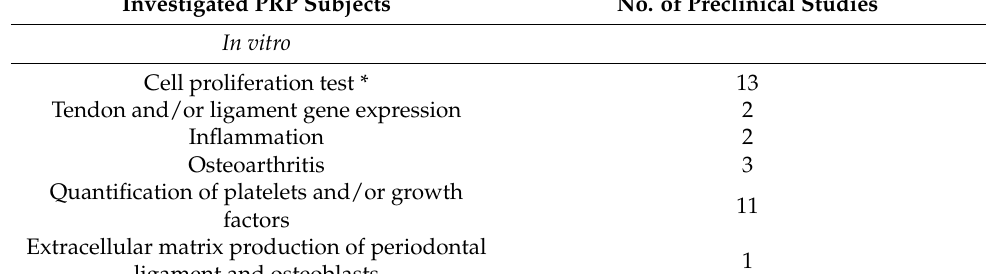
Figure 6. Type distribution of articles. Bar graph showing the median number of citations (and maximum) for the most-cited articles according to the article type distribution of articles (number of articles at the bottom of the bar). * The Kruskal–Wallis test showed significant difference in citations per article among the various types of articles ( p < 0.05).